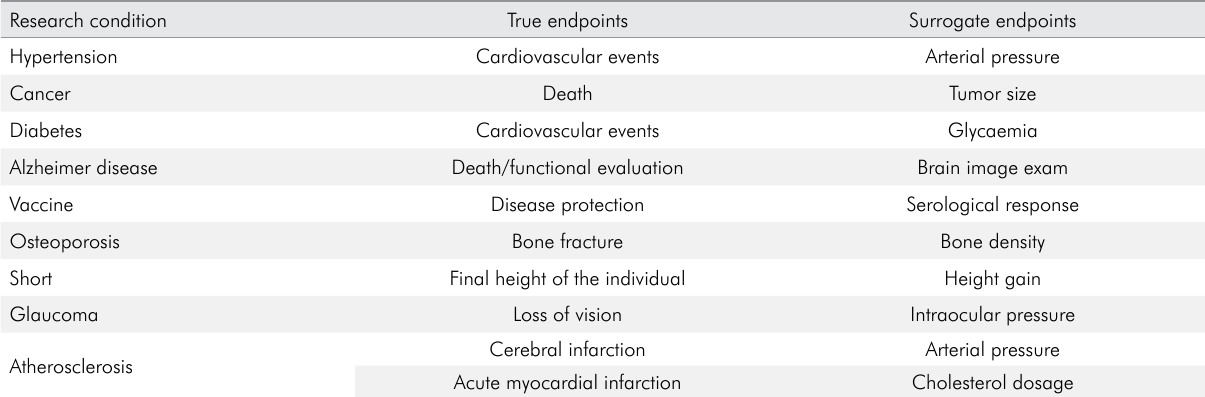
Table 1. Some samples of true endpoints and surrogate endpoints in